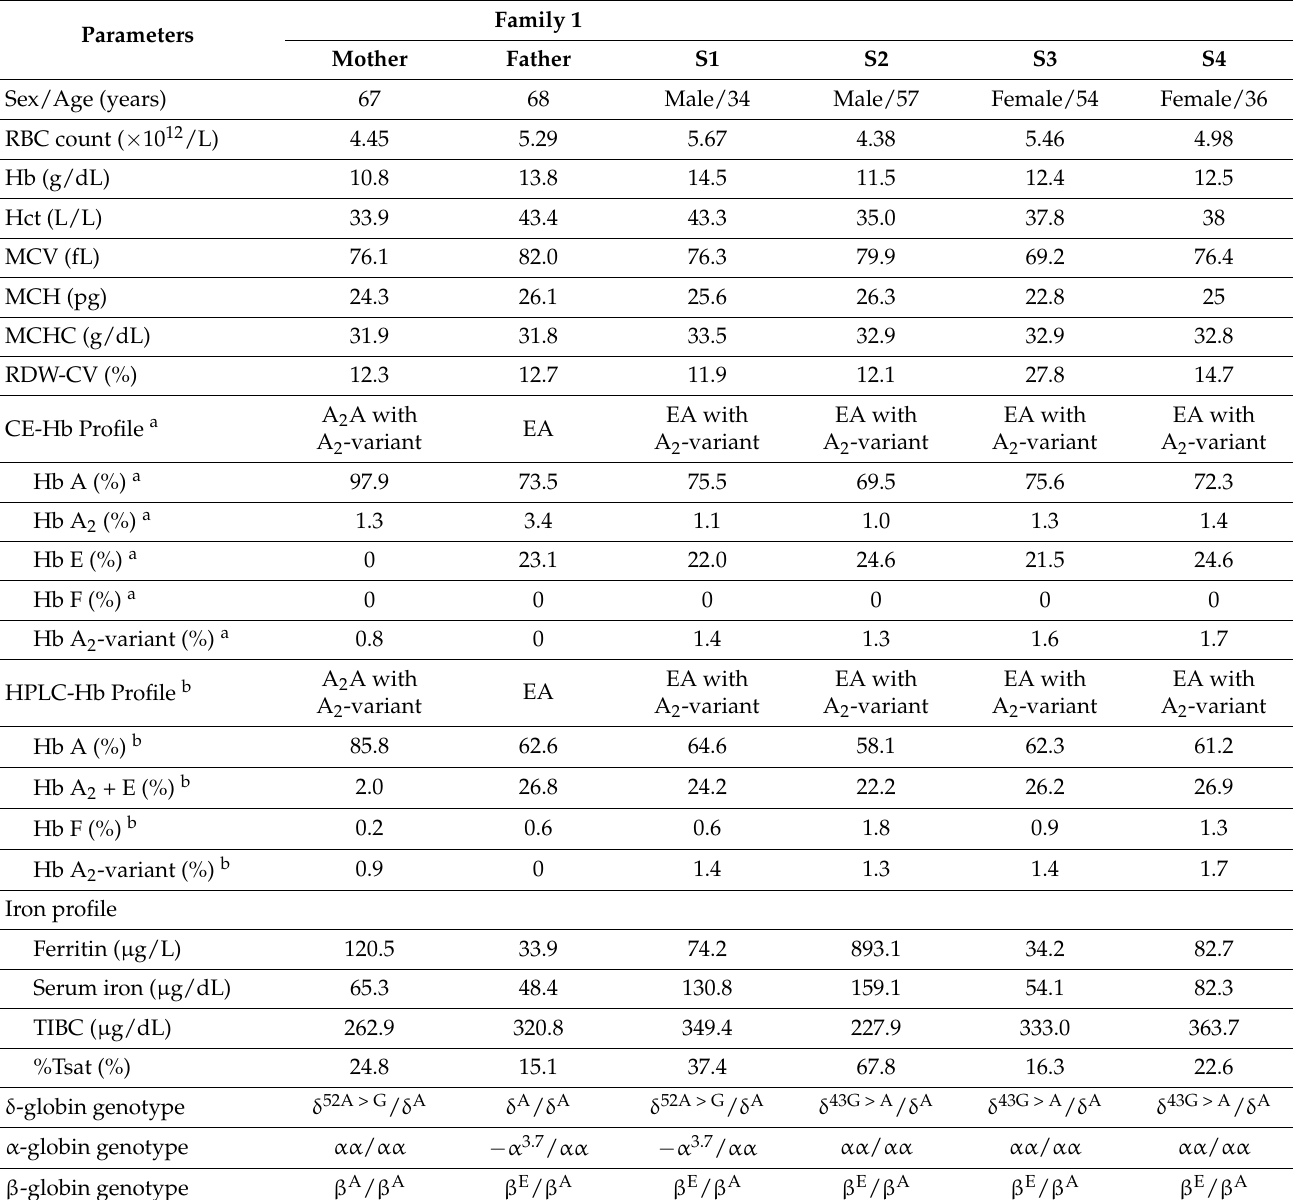
Table 1. Hematological data and globin genotypes of the subjects carrying Hb A 2 -variants and the parents of the subject carrying Hb A 2 -Mae